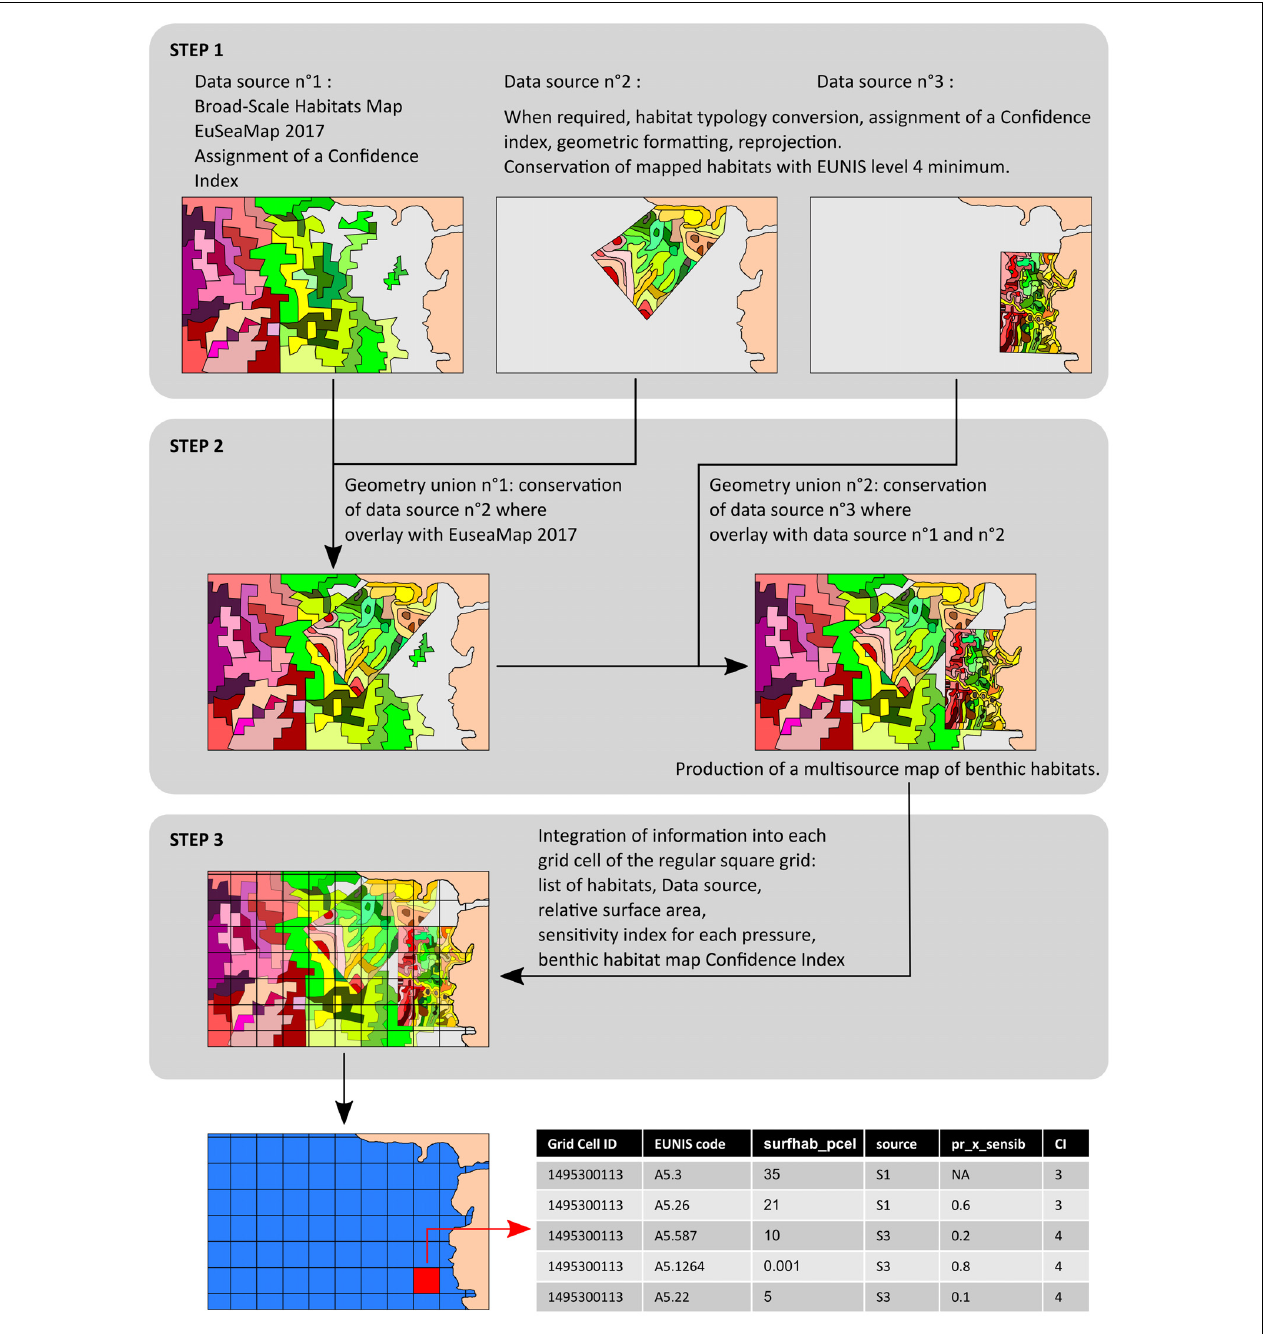
FIGURE 4 | Main steps of building the multisource map of benthic